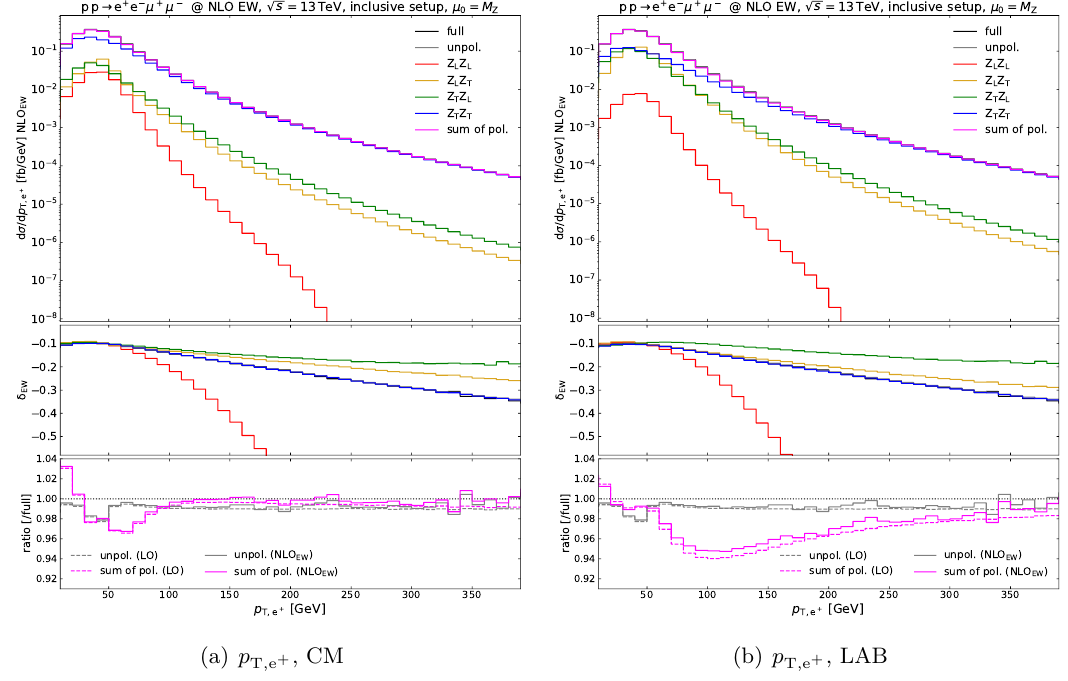
Figure 8 . Distributions in the positron transverse momentum. Polarizations are defined the CM (a) and in the LAB (b) frame. Same structure as in figure